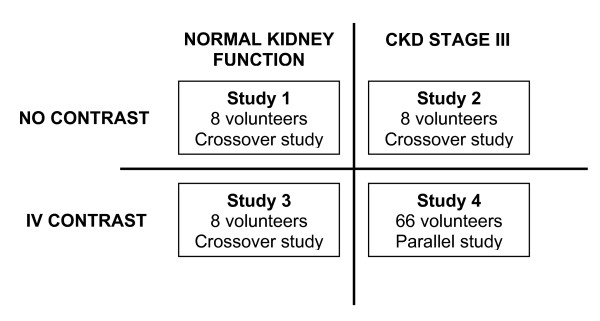
4 way study design.